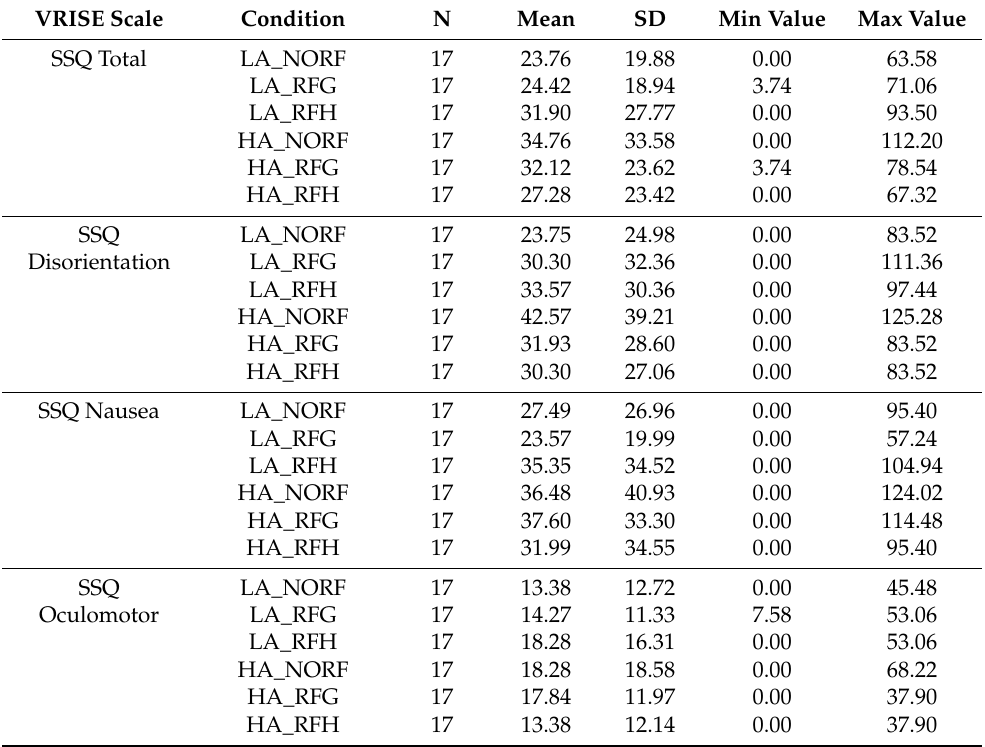
Table 13. Subjective VRISE levels assessed by the SSQ, FMS, and VRNQ (VRISE Section) Question- naire for the participants experienced with VR Technology.